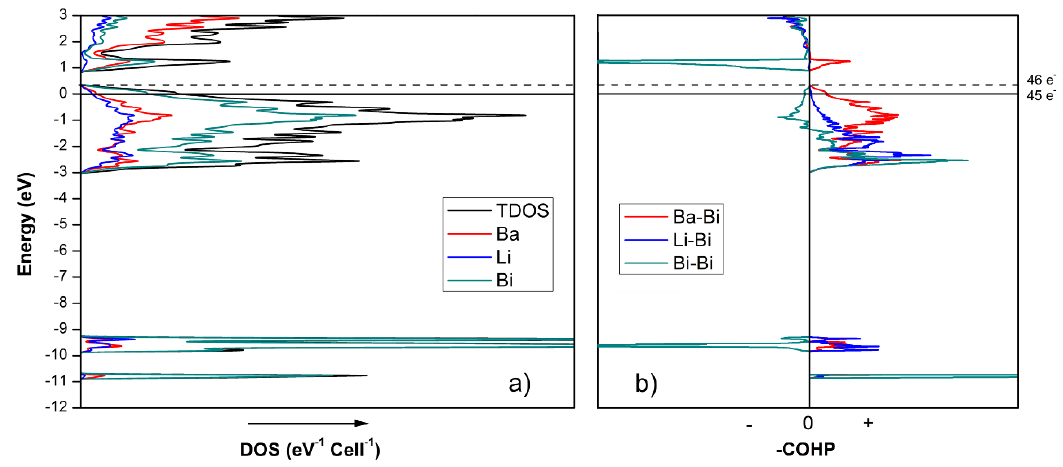
Figure 5. ( a ) Projected total and partial density of states (DOS) for Ba 4 Li 7 Bi 6 . The partial DOS curves illustrate the contribution of different atoms to the total DOS ( E F = 0 eV). ( b ) Crystal orbital Hamilton population (COHP) plots for Ba–Bi, Li–Bi and Bi–Bi interactions shown on the same energy scale. The COHP values are inverted, which is done so that “ − ” and “+” denote the antibonding and bonding regions, respectively.